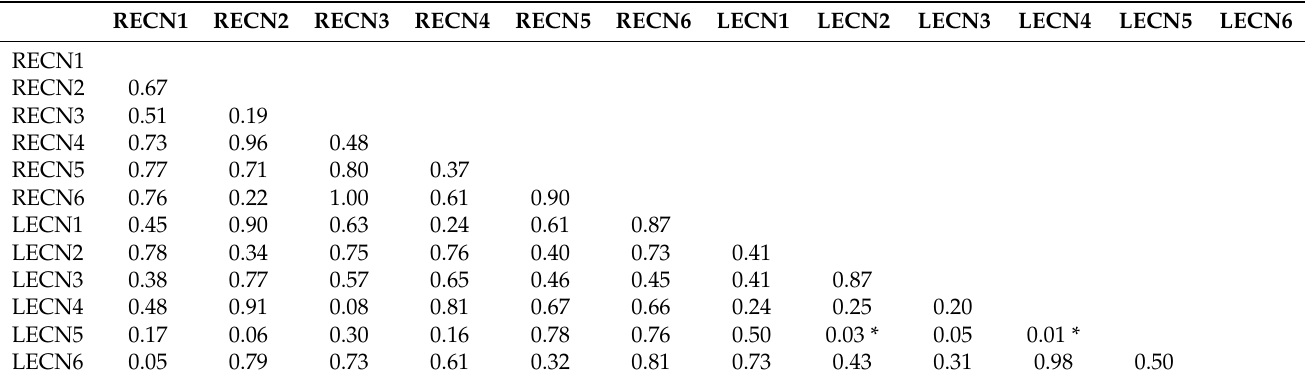
Table 4. Function connectivity results for 12 ROI–ROI changes in ECN, segregated by time point.